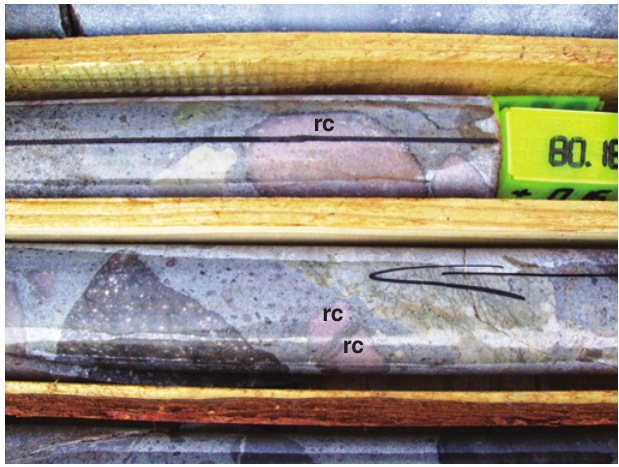
Figure 4. Distinct chemical weathering rim around light pink rhyolitic clasts (rc) possibly recording weathering conditions and/or redox conditions on the early Earth’s surface.